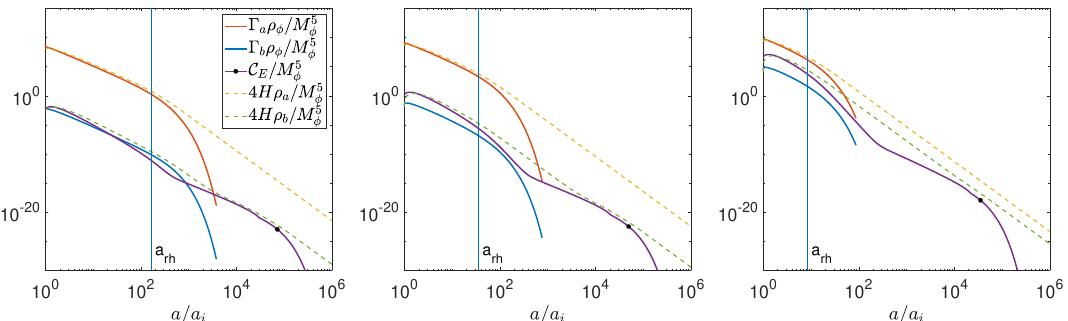
Figure 11. Comparison of the collision term with the in(cid:13)aton decay terms into the two sectors. The plots are for parameters f (cid:0) 0 a = 10 (cid:0) 11 , w = 10 (cid:0) 8 g (left), f (cid:0) 0 a = 10 (cid:0) 10 : 5 , w = 10 (cid:0) 8 g (center) and f (cid:0) 0 a = 10 (cid:0) 10 , w = 10 (cid:0) 4 g (right). The vertical blue line denotes the point where reheating occurs. In these plots 4 H(cid:26) a;b serve as proxies for the temperatures of the two sectors. Since we have taken (cid:11) a = (cid:11) b , the temperature ratio is simply x = (4 H(cid:26) b = 4 H(cid:26) a ) 1 = 4 .